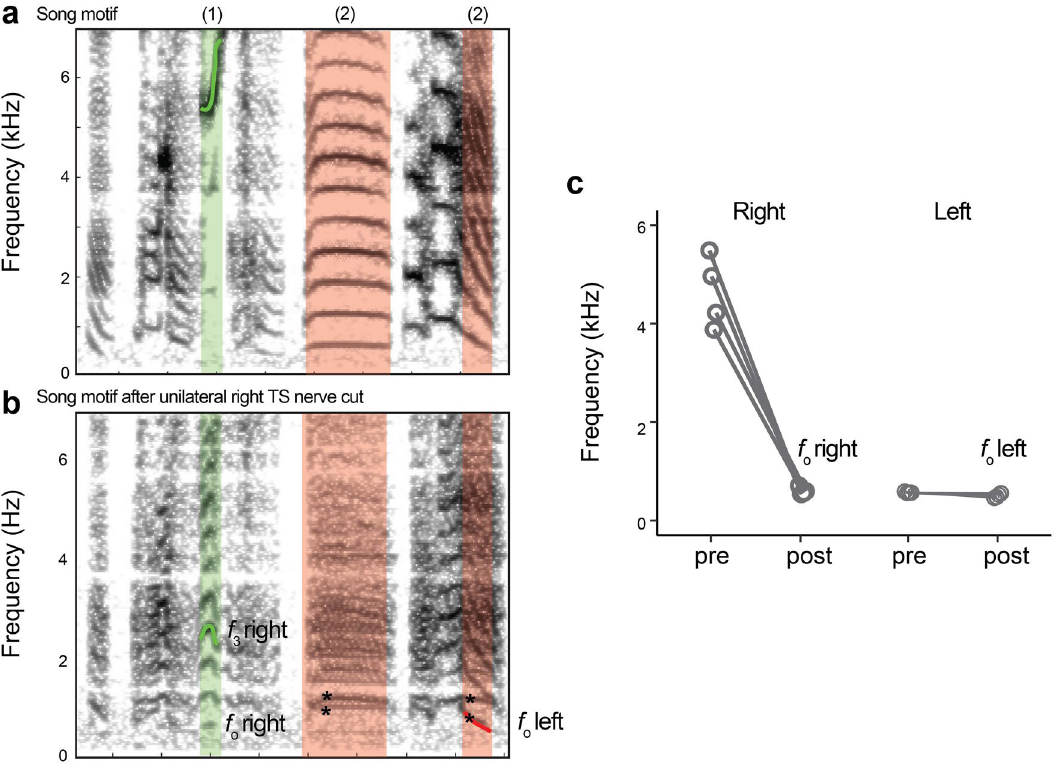
Figure 8. Minimal frequencies produced by the adult left and right hemi-syrinx during song in vivo. Unilateral (right) tracheosyringeal nerve cuts allowed the assignment of left or right produced frequency component in some syllables during song. ( a ) Comparing spectrograms before and ( b ) after nerve cuts on the right side, we observed three types of syllable changes: (1) The f o of high frequency (4–6 kHz) syllables decreased (green box). Because we did not observe two simultaneous frequencies in high f o notes after nerve cuts, we could reliably assign high notes to be produced by the right hemi-syrinx. (2) In all animals we observed syllables with two simultaneous f o trajectories (asterisks) after nerve cuts (orange boxes). This suggested that these syllables were produced by contributions from both sides, and refutes bilateral mechanical injection coupling within those syllables (see “Methods”). Here we could also unambiguously assign the unchanged f o time trajectory to the left side. ( c ) Minimal frequencies before and after nerve